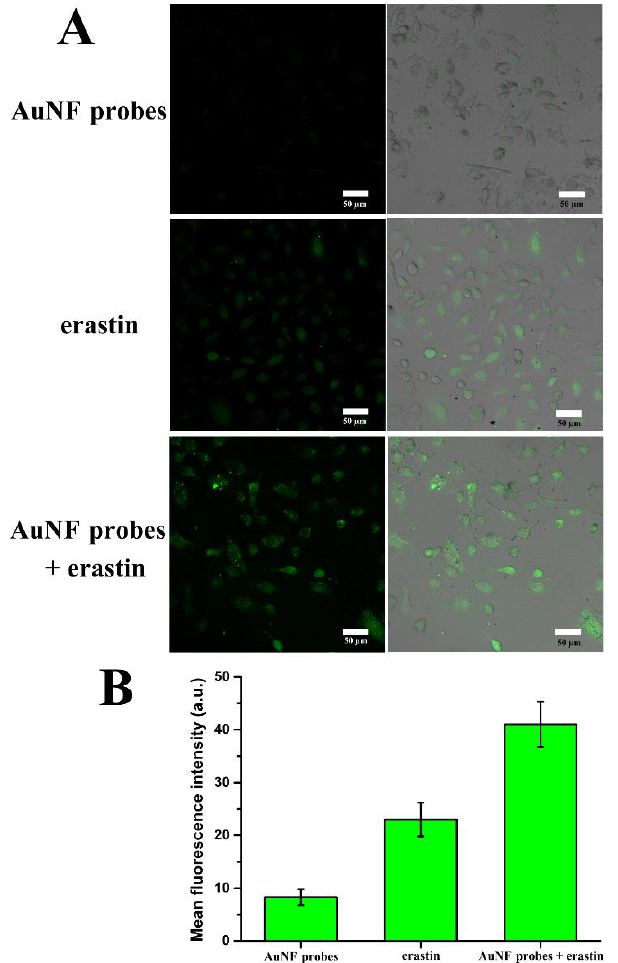
Figure 7. ( A ) Confocal images of HeLa cells showing the ROS response when cells were treated by different systems. ( B ) Mean fluorescence intensity of confocal images of HeLa cells shown in ( A ).